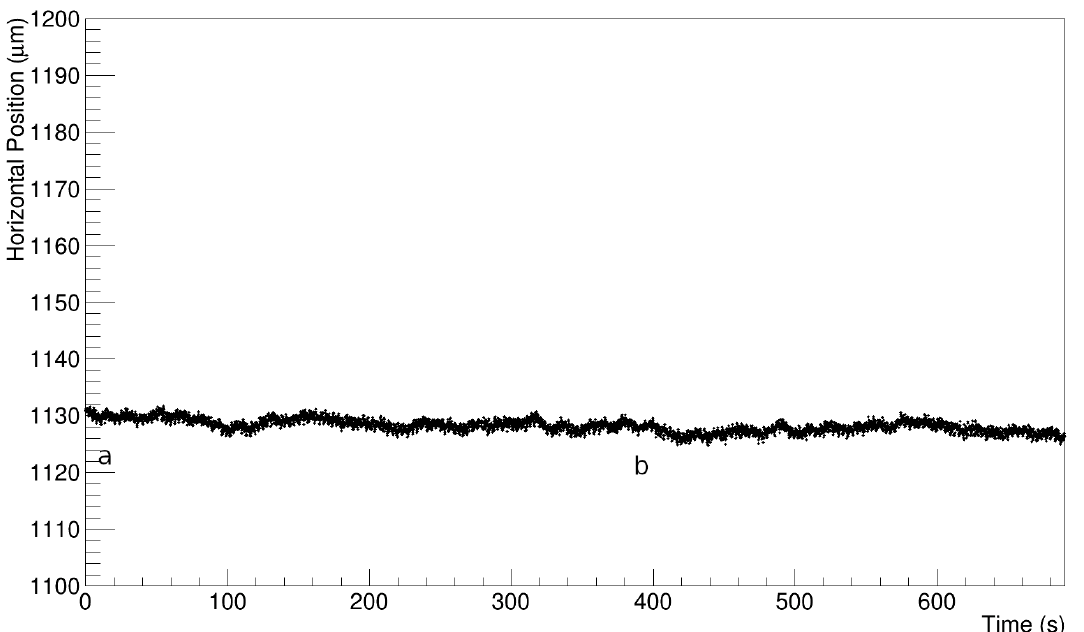
Figure 12. Horizontal X-ray beam position measured by NanoMAX. Changes of the BiomaX bumps at done at points “a” and “b” using the WOBBL tool. No significant perturbations can be observed due to the applied changes. See main text for